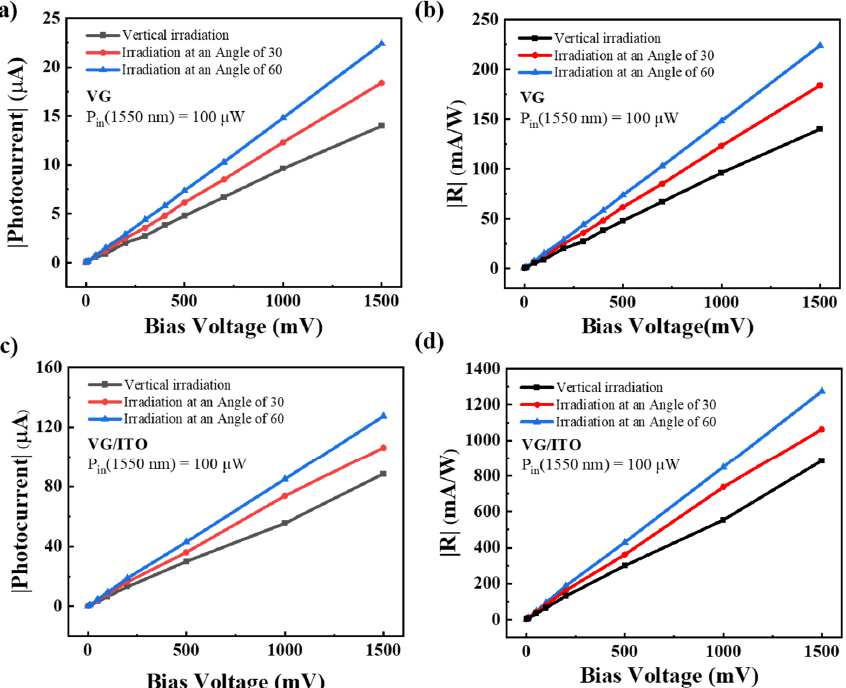
Figure 5. Dependence of photocurrent and photoresponsivity on bias voltage at varied incident angles (0 ◦ , 30 ◦ , 60 ◦ ). ( a ) |I ph | at various bias voltages V bias for VG photodetector. ( b ) Photoresponsivity ( | R | ) as a function of V bias for VG photodetector. ( c ) |I ph | at various bias voltages V bias for VG/ITO photodetector. ( d ) Photoresponsivity ( | R | ) as a function of V bias for VG/ITO photodetector.